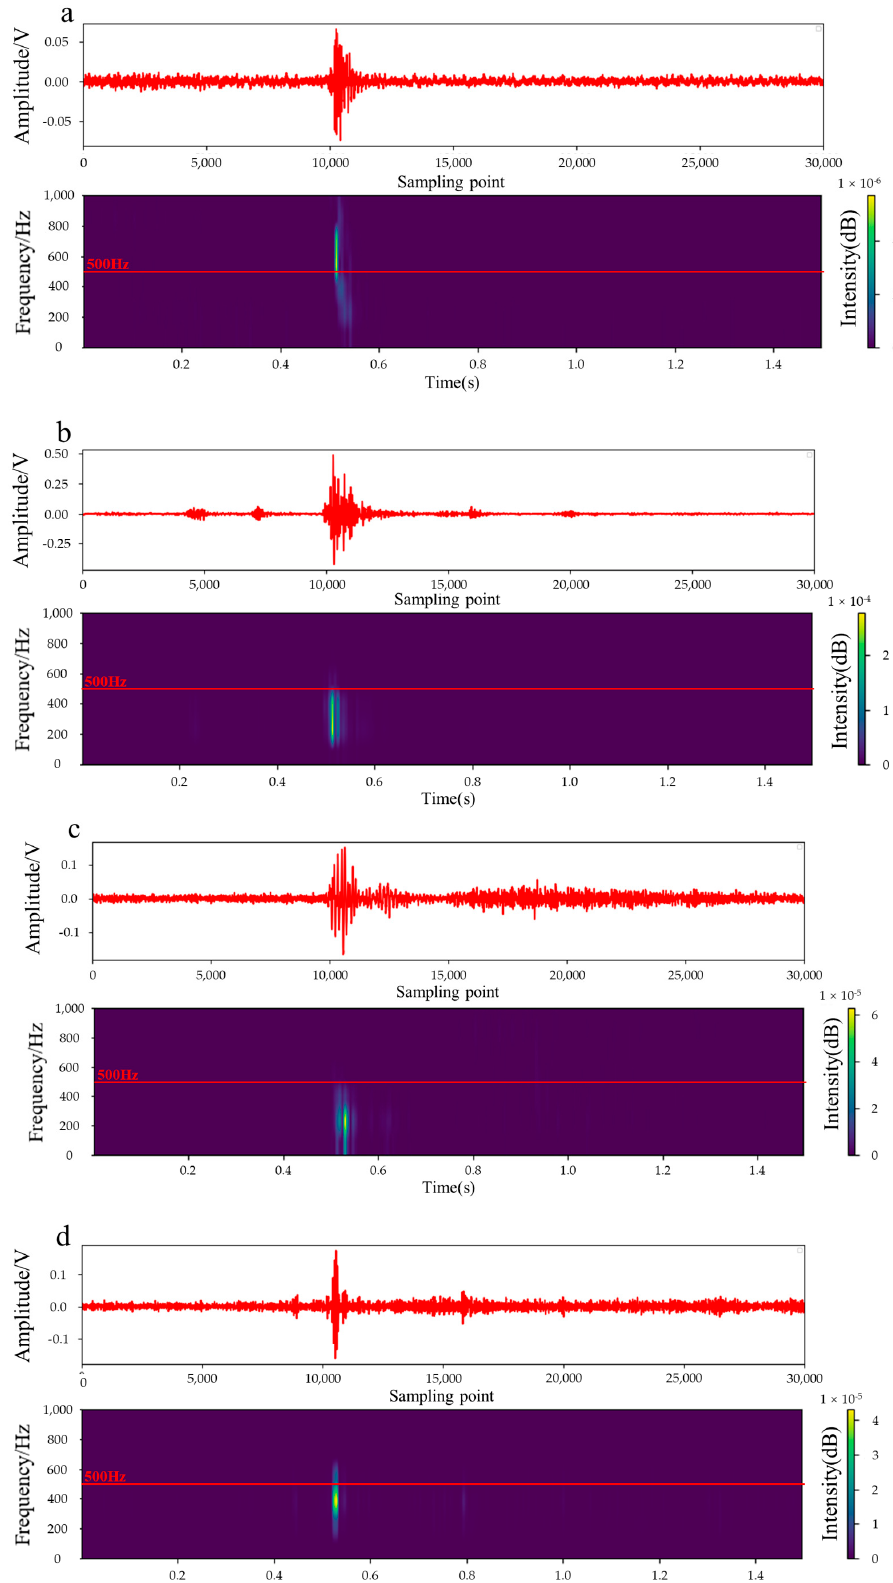
Figure 10. Typical low-SNR microseismic signal, ( a ), and SN signals, ( b )–( d ).